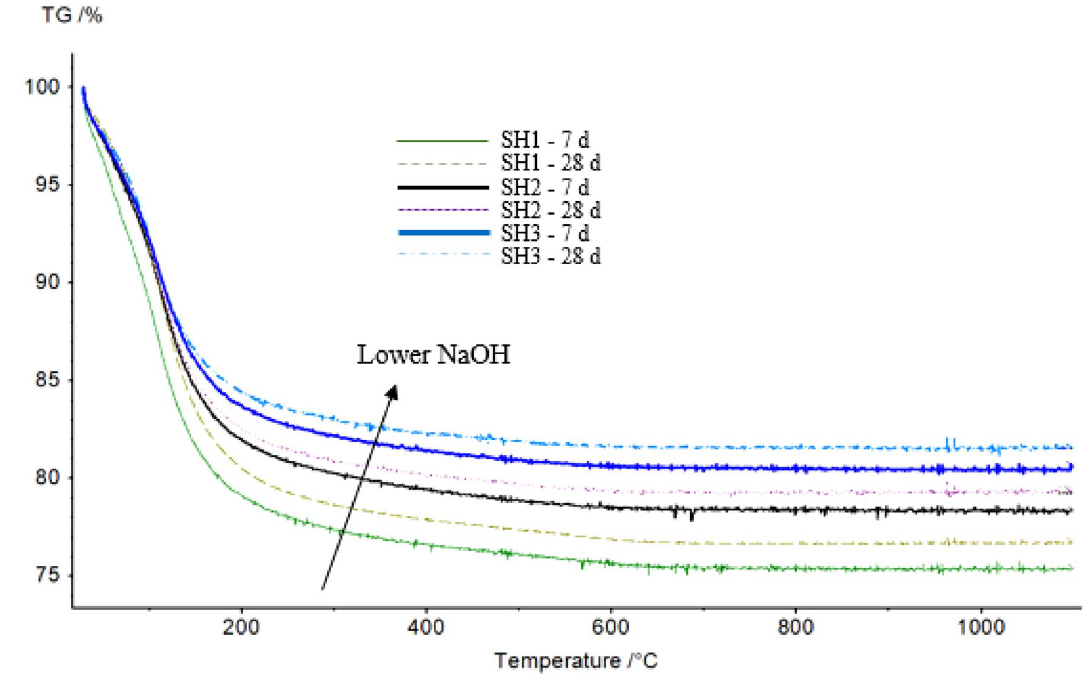
Fig. 8 TGA curves of SH1, SH2 and SH3 at 7 and 28